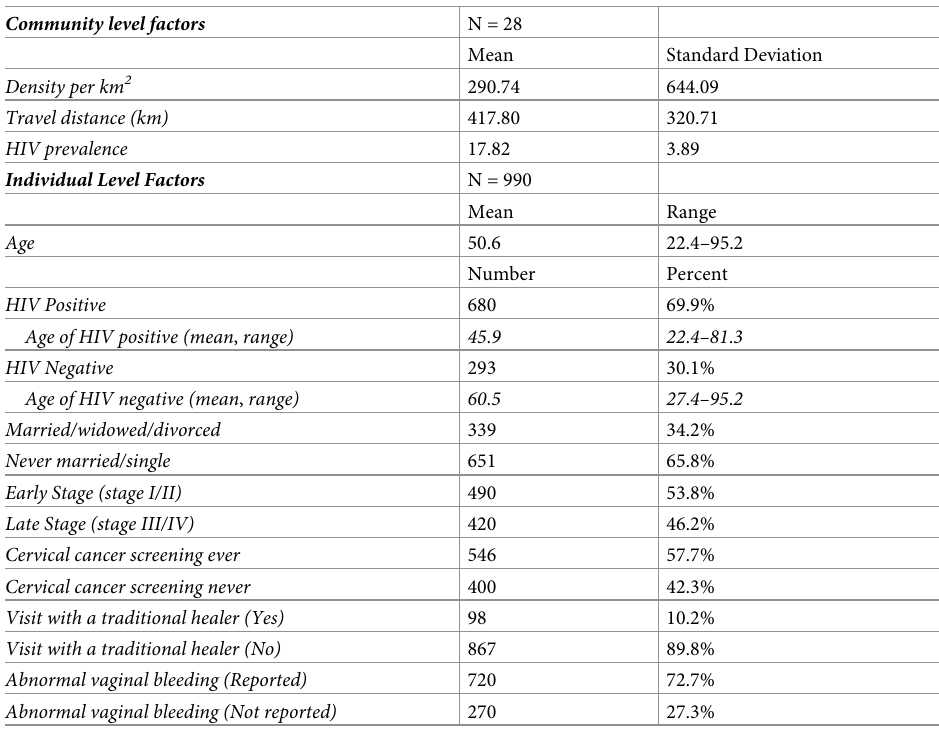
Table 1. Community and individual level characteristics of sub-districts and the study